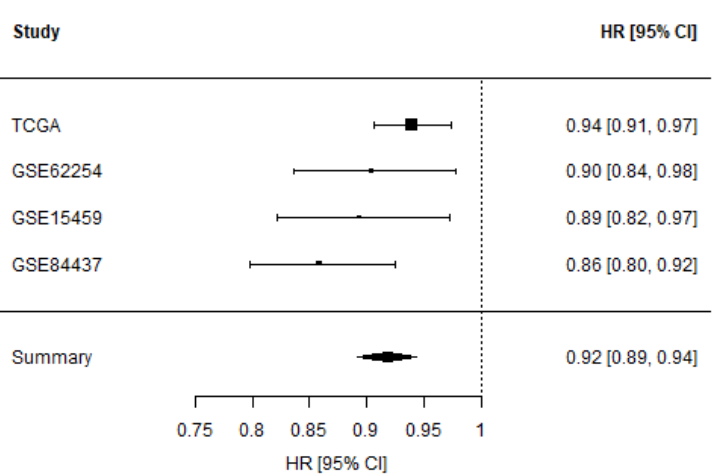
Figure 10. Forest plot of estimated hazard ratios indicating STEM score as a prognostic factor for OS in four GC cohorts.